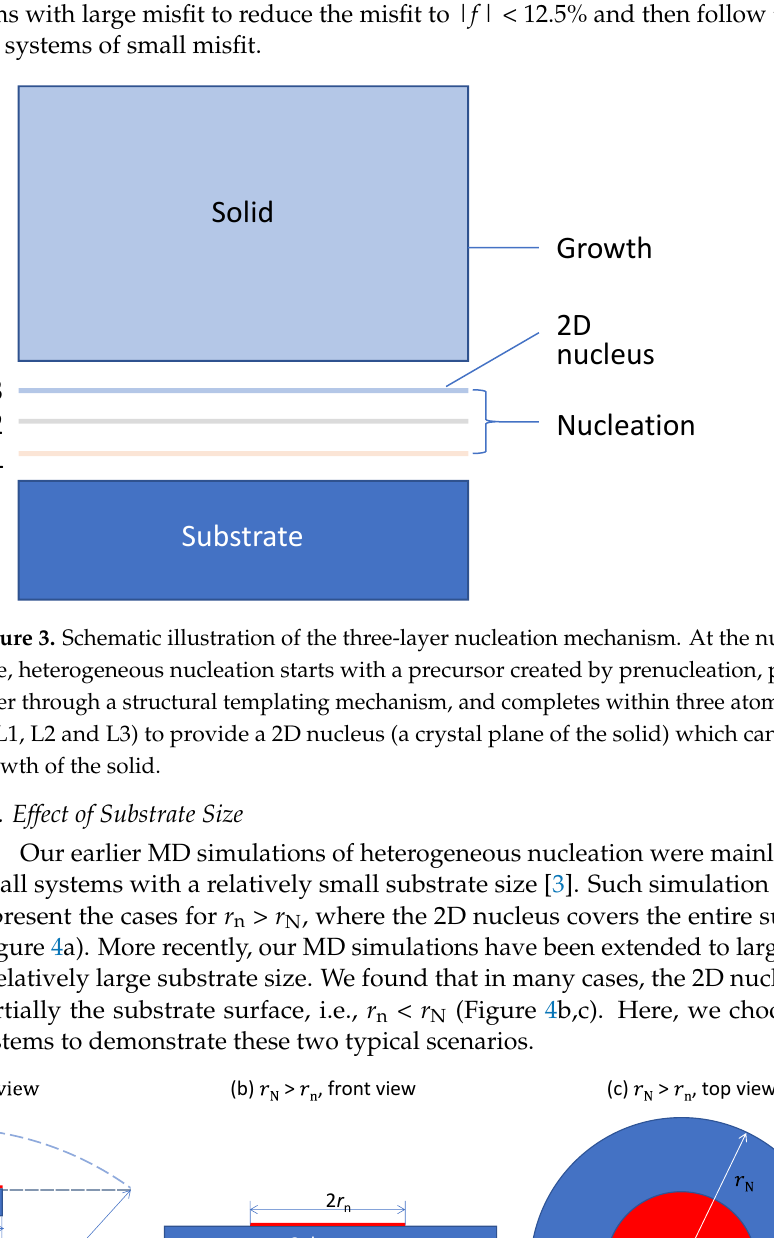
dislocation mechanism for systems with small negative misfit ( − 12.5% < f < 0); vacancy mechanism for systems with small positive misfit (0 < f < 12.5%); and the formation of a coincidence site lattice (CSL) as the new substrate at the stage of prenucleation for the sys- tems with large misfit to reduce the misfit to | f | < 12.5% and then follow the mechanisms for systems of small misfit.